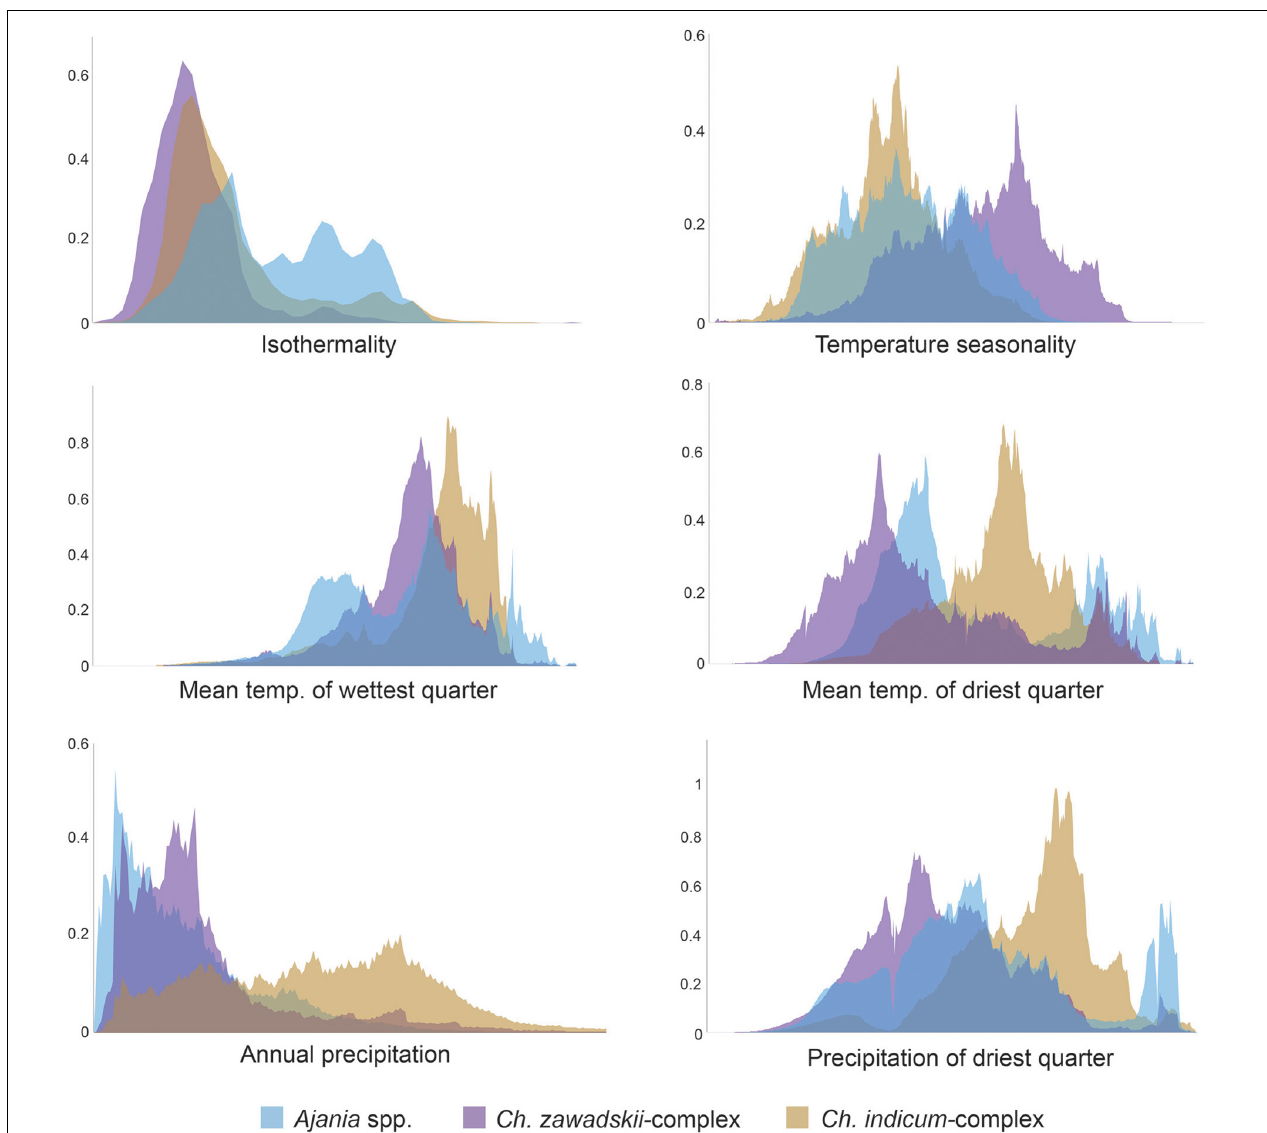
FIGURE 5 | Diagrams displaying niche overlaps among three major lineages. Suitability diagrams were converted from potential distribution and ecological data according to the strategy reported by Evans et al. (2009). The x -axis indicates the adaptive range of such ecological factors, and the y -axis indicates suitability. Different colors correspond to different lineages, as shown in the legend at the